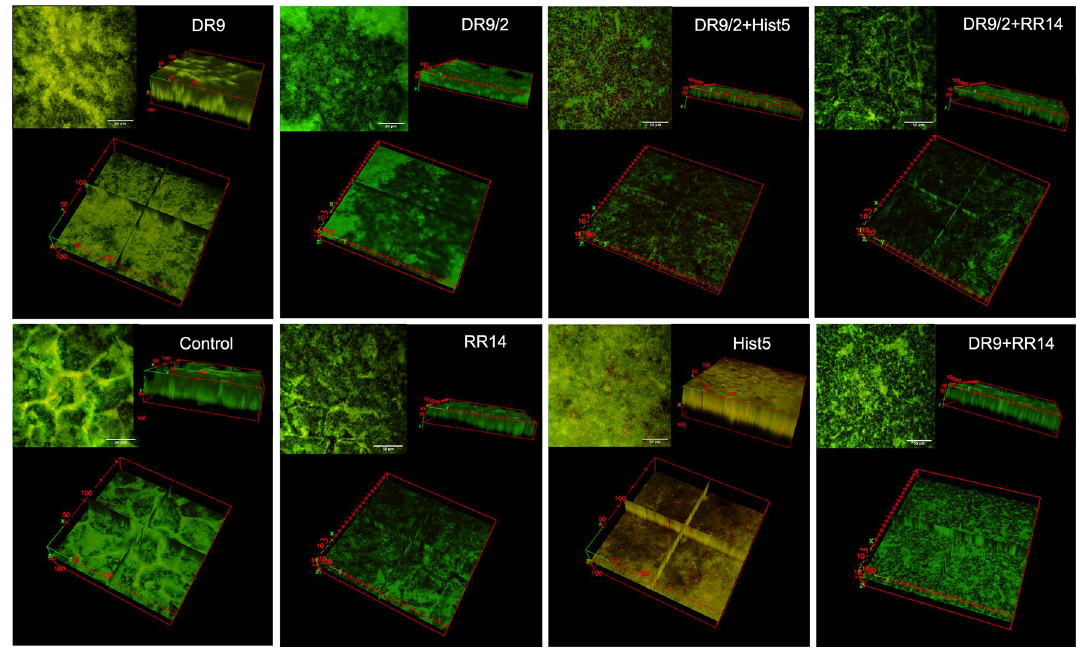
Figure 6. 2-photon fluorescence 3D renderings of 24 h S. mutans U159 biofilms grown in cariogenic conditions on hydroxyapatite (HA) discs pellicle-coated with selected protein/peptide candidates: This characterization method aimed to monitor the biofilm structure and vitality across the entire biofilm thickness. Biofilms stained with Syto-9 “live/green” and propidium-iodide “dead/red” stains. On each cluster, 2D sum of z-stack slices “z-projection” is in the upper left (the scale bar is 50 μm), the 3D volume of biofilms is in the upper right, and an ortho middle slice of the z-stack is in the bottom. The z-projection is collapsing the data from 3 dimensions into 2 dimensions giving every pixel value an influence on the result. The 3D volume show the thickness of bacterial biofilms in μm. The ortho middle slice shows the biofilm’s structure and/or vitality at the middle of its thickness. Hist5,